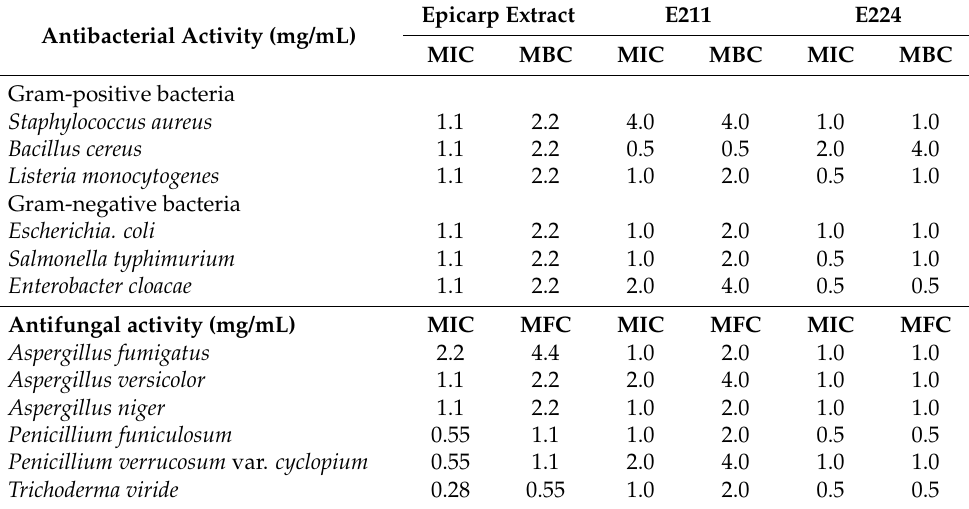
Table 4. Antibacterial and antifungal activities of S. odorifera epicarp hydroethanolic